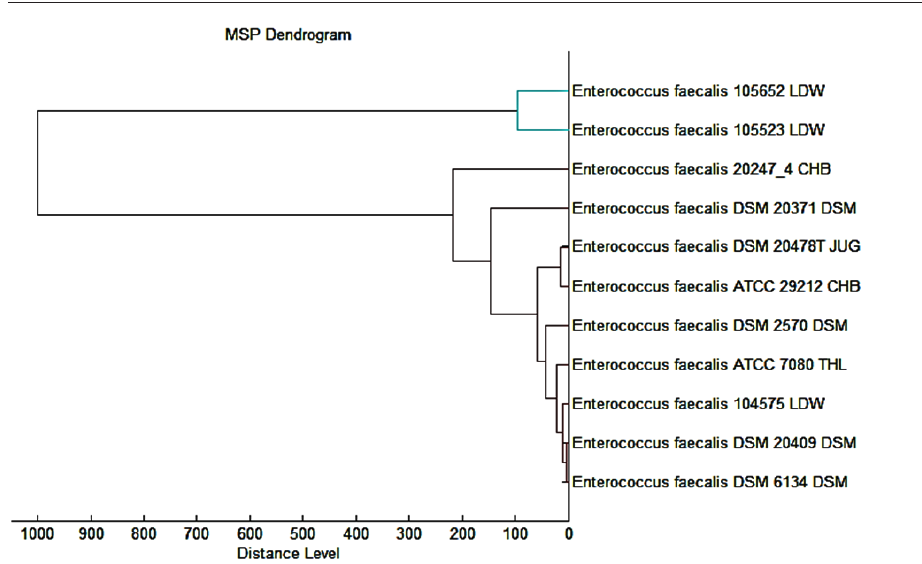
Fig. 5. The MSP dendrogram for 52 E. faecalis strains exhibited a strong relationship with 11 E. faecalis reference strains in the Bruker